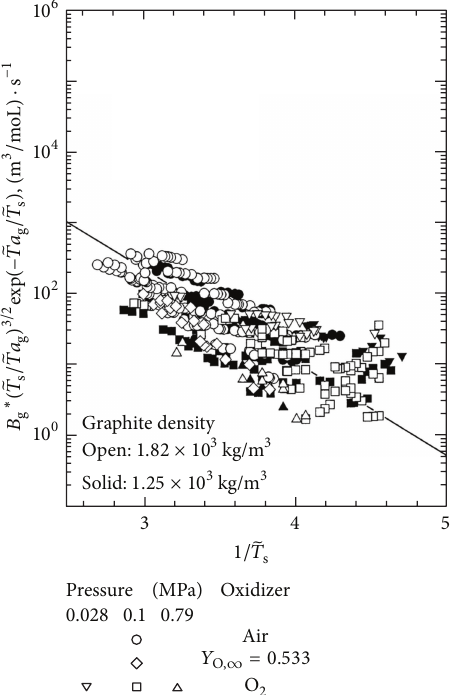
Figure 4: Arrhenius plot of the global gas-phase reaction [42], obtained from the experimental results of the ignition surface- temperature in two-dimensional stagnation flows with various pressures, O 2 and H 2 O concentrations, and velocity